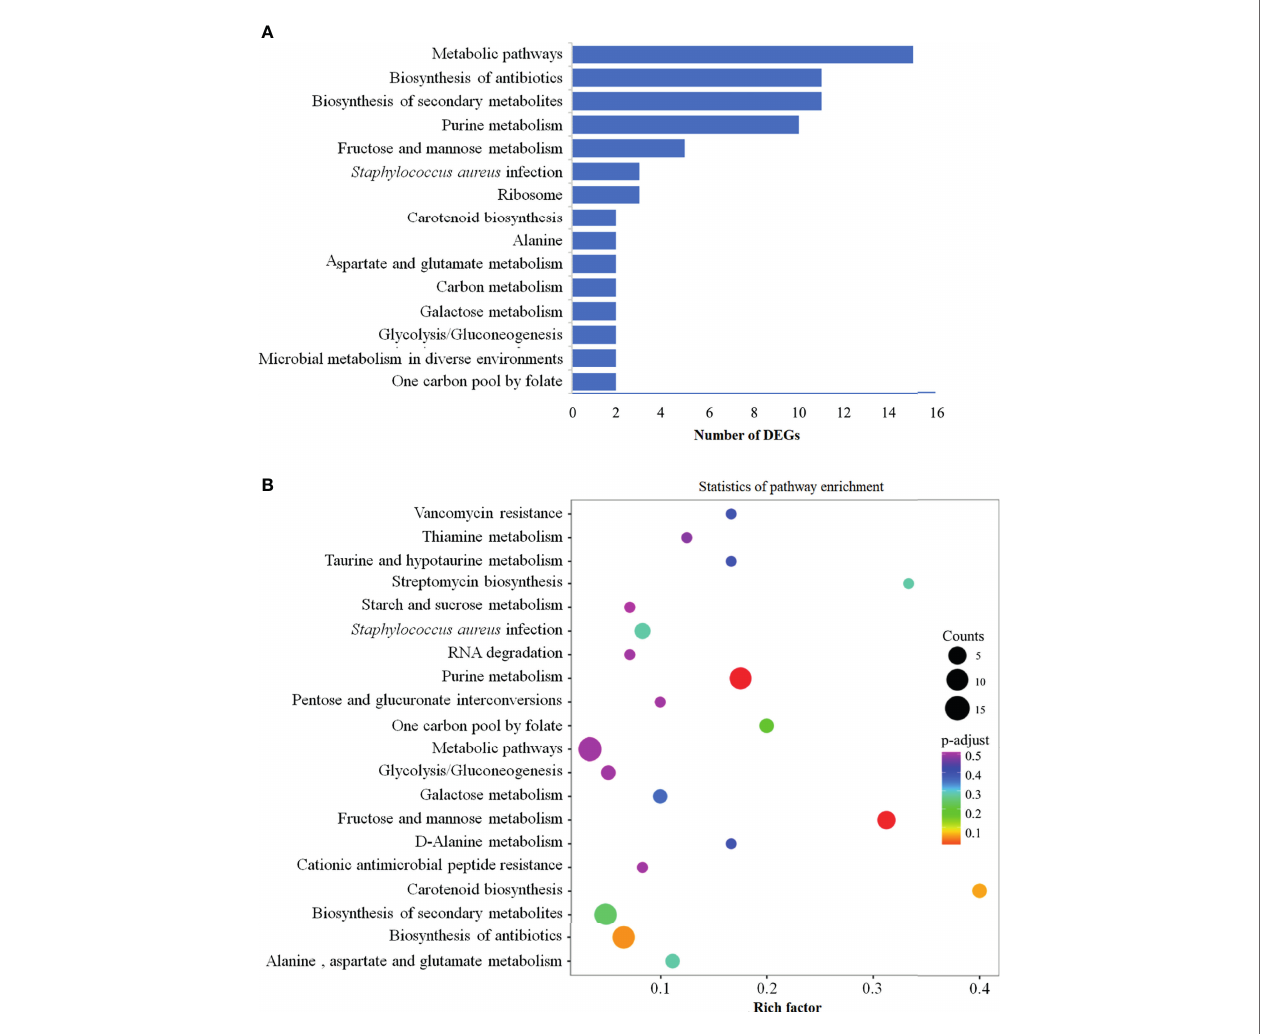
FIGURE 3 | KEGG pathway enrichment analysis of DEGs. KEGG pathway enrichment analysis was conducted based on the KEGG database (R package GOseq v 1.18). (A) Top 15 enriched KEGG pathways among DEGs. These 15 pathways are arranged in the order of number of DEGs, and the pathways enriched the most DEGs are metabolic pathways, followed by biosynthesis of antibiotics, biosynthesis of secondary metabolites and purine metabolism. (B) Visualization of the 20 most signi fi cant KEGG enrichment pathway. The 20 most signi fi cant pathways were selected by combining three factors: enrichment factor (x-axis), P value (color of the dots) and number of genes enriched (size of the dots). KEGG, Kyoto Encyclopedia of Genes and Genomes; DEGs, differentially expressed